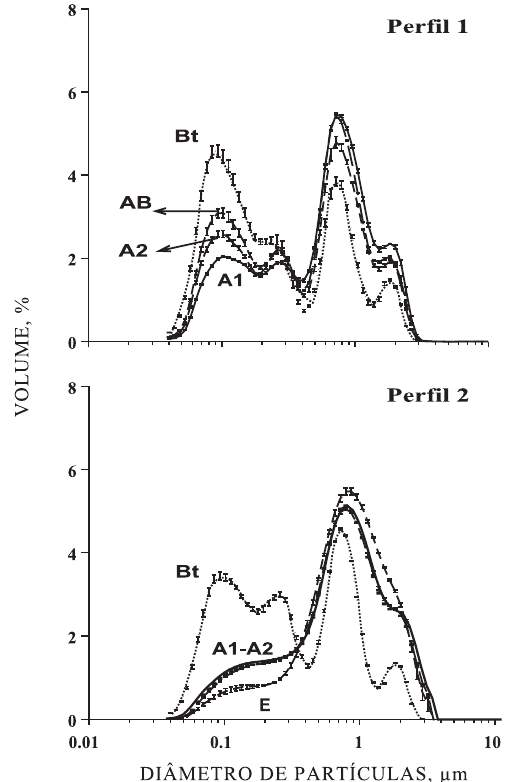
Figura 2. Diagramas de difração laser representando a distribuição do tamanho de partículas em percentual de seus volumes em cada classe. Fração argila dos horizontes de um Argissolo Vermelho-Amarelo distrófico abrúptico, perfil 1, localizado em meia encosta sob campo nativo e perfil 2, em topo de coxilha sob vegetação